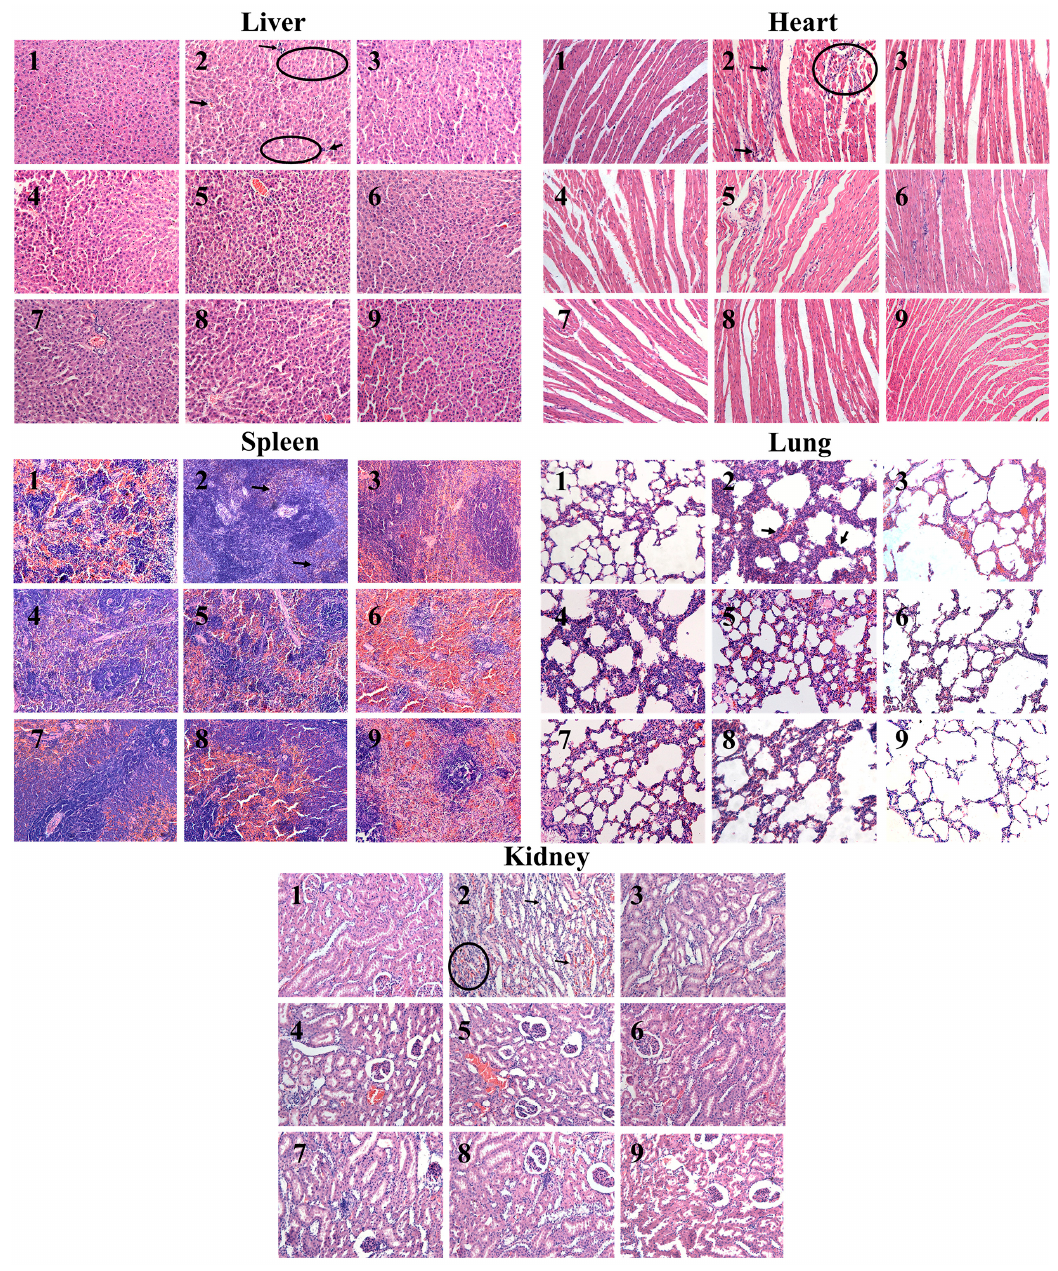
Figure 5. H&E staining results of tissues (200× magnification). 1 – 9 represent the C, M, P, CMFL, CMFM, CMFH, CIFL, CIFM, and CIFH groups, respectively.